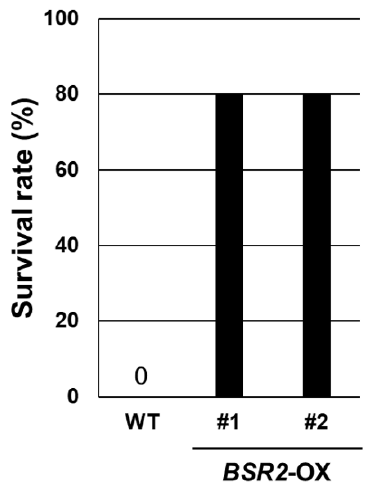
Figure 2. Survival ratio of transgenic torenia against R. solani (MAFF235116: AG-4IIIA) in the soil inoculation assay. Two-week-old BSR2 -OX lines were transplanted into the infected soil inoculated with R. solani , and the survival ratios were calculated 5 days after inoculation ( n = 5).